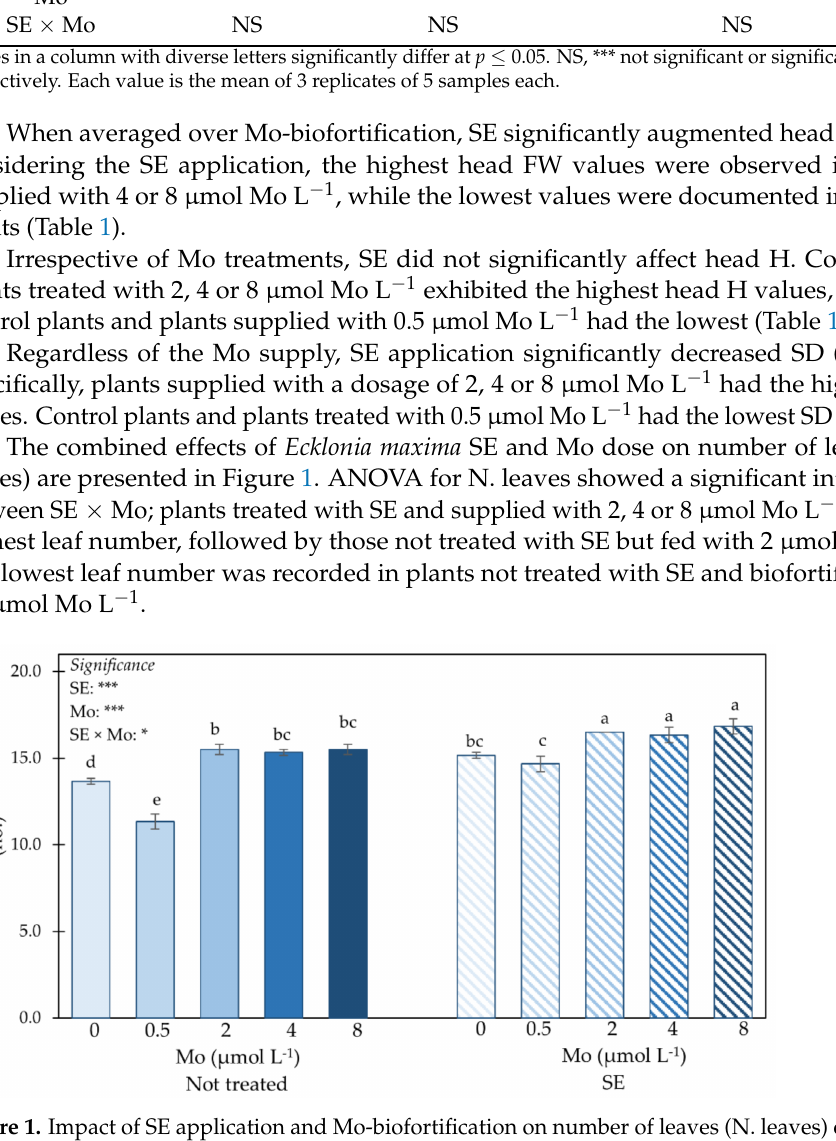
Figure 1. Impact of SE application and Mo-biofortification on number of leaves (N. leaves) of spinach plants cultivated in a protected environment. Values with diverse letters significantly differ at p ≤ 0.05. *, *** significant at 0.05 or 0.001, respectively. Bars indicate mean ± standard error of 3 replicates of 5